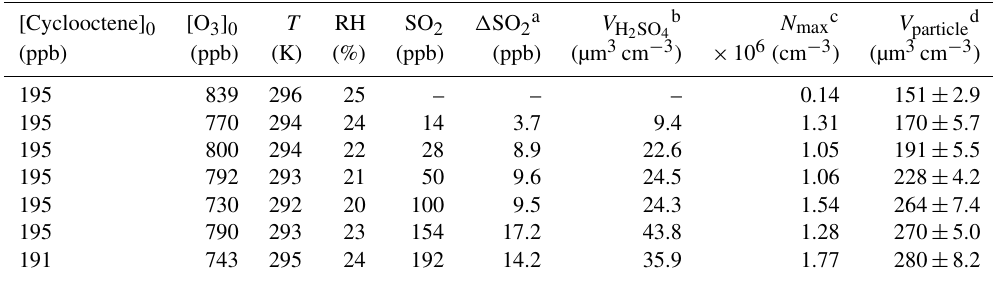
Table 1. Experimental conditions and results for particle-formation experiments. [Cyclooctene] 0 [O 3 ] 0 SO